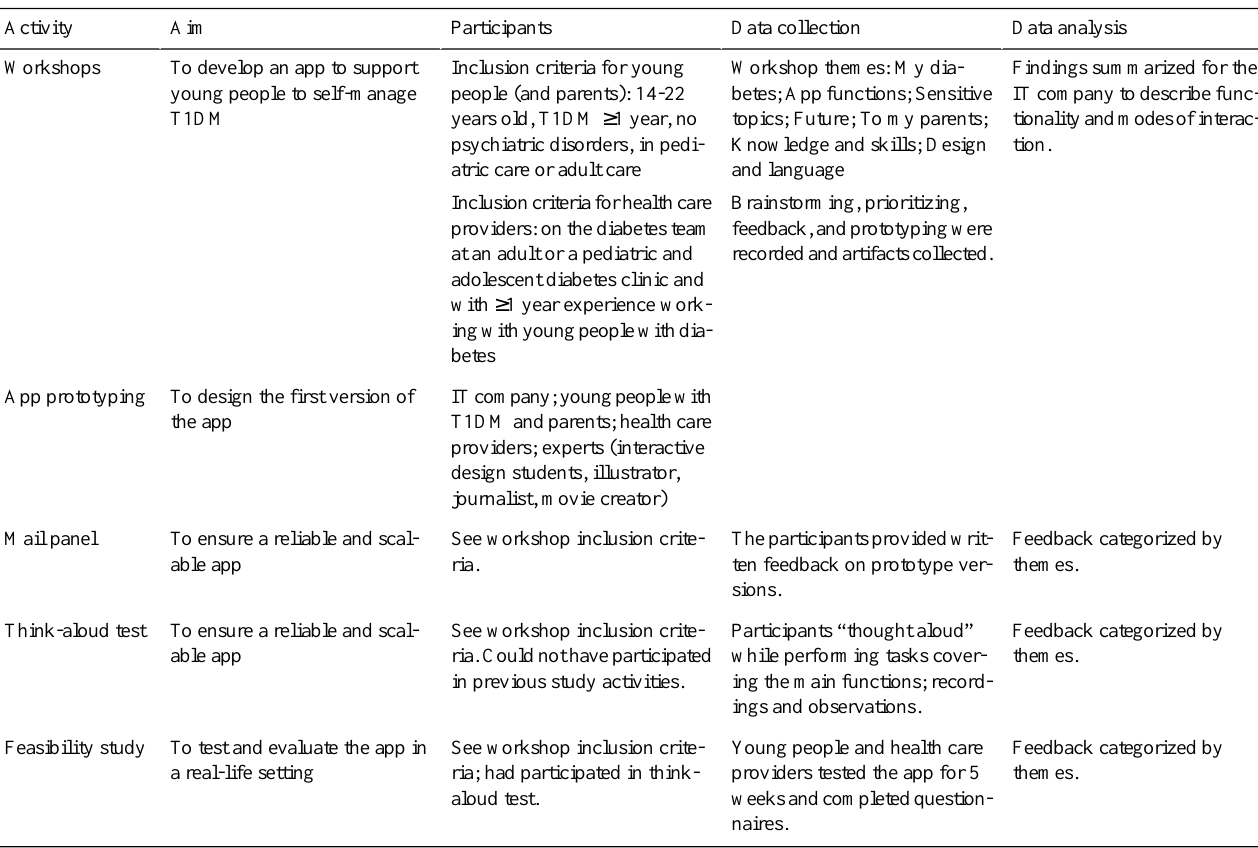
Table 1. Detailed description of app